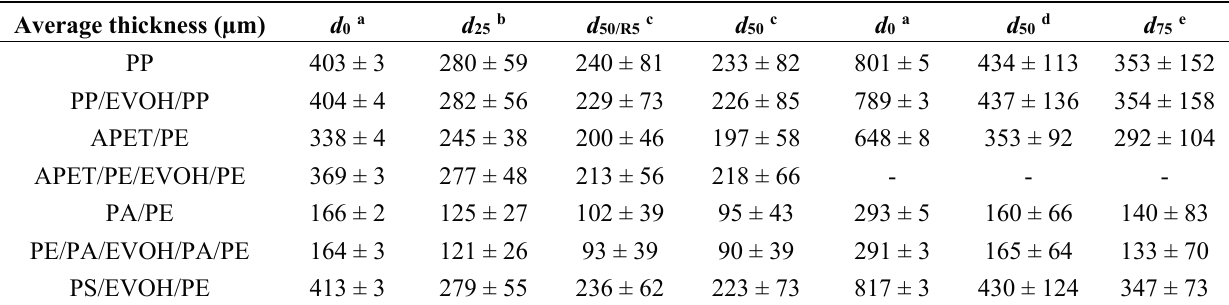
Table 3. Average thickness ± standard deviation of all sheets and trays expressed in